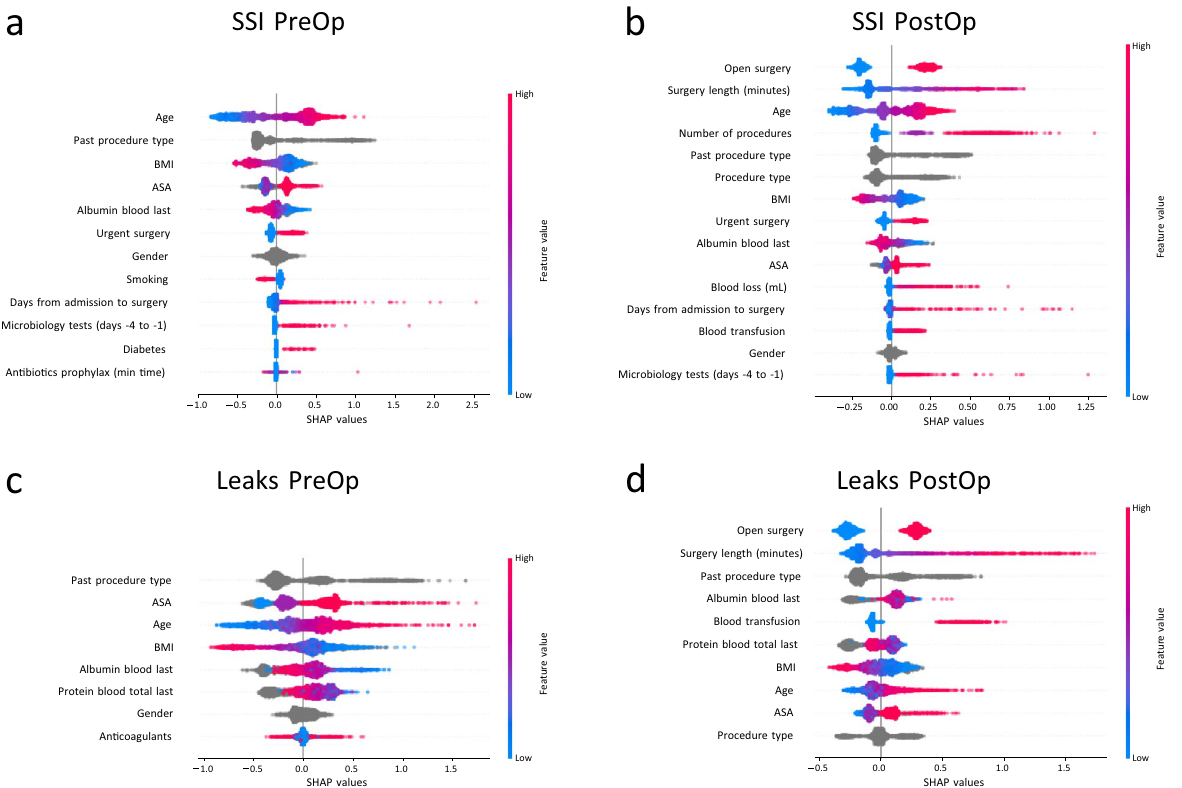
Figure 1. Literature-Informed Risk Prediction Models Figure shows SHAP summary plots displaying the effect of a feature and its value on the prediction. The y-axis of each plot contains the features included in the model sorted from the most (top) to least (bottom) important. The x-axis depicts the SHAP value. Each point refers to a SHAP value associated with a value of a certain feature. The color of the point displays whether the feature value is high (pink) or low (blue). Grey-colored points are categorical and missing values. Example: Age in subplot A: Older ages (red-colored points) increase the risk of SSI (SHAP value 0.5 to 1), lower ages (blue- colored points) reduce the risk (SHAP values − 0.9 to − 0.5). ( A ) Preoperative SSI model ( B ) Postoperative SSI model ( C ) Preoperative Leak model ( D ) Postoperative Leak